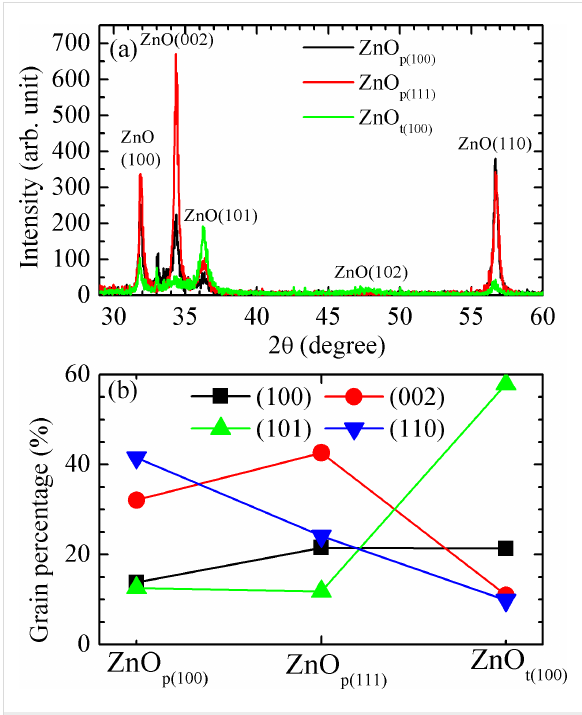
Figure 1: (a) XRD and (b) grain percentages obtained from integra- tion of the intensity of the XRD peaks of the samples ZnO p(100) , ZnO p(111) , and ZnO t(100)